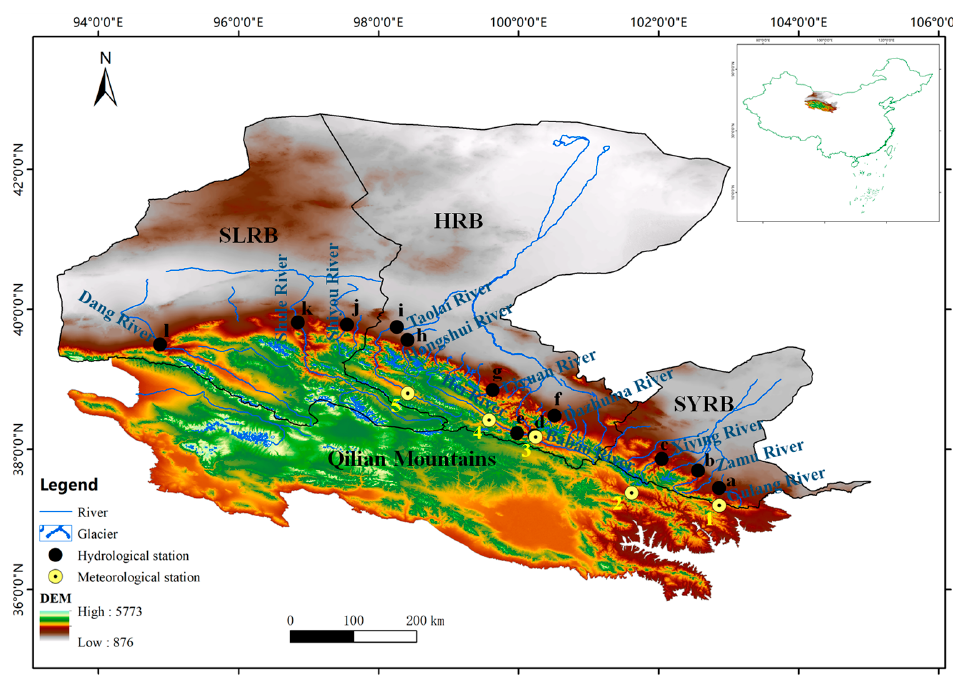
Figure 1. Location of the study area. (a − c) Denote Gulang, Zamu, and Xiying rivers in SYRB, (d − i) (d–i) denote Babao, Hei, Dazhuma, Liyuan, Hongshui, and Taolai rivers in HRB, (j–l) denote Shiyou, denote Babao, Hei, Dazhuma, Liyuan, Hongshui, and Taolai rivers in HRB, (j − l) denote Shiyou, Shule, and Dang rivers in SLRB, respectively. (1 − 5) Denote Wushaoling, Menyuan, Qilian, Ye- Shule, and Dang rivers in SLRB, respectively. (1–5) Denote Wushaoling, Menyuan, Qilian, Yeniugou niugou and Tuole meteorological stations, respectively. and Tuole meteorological stations,